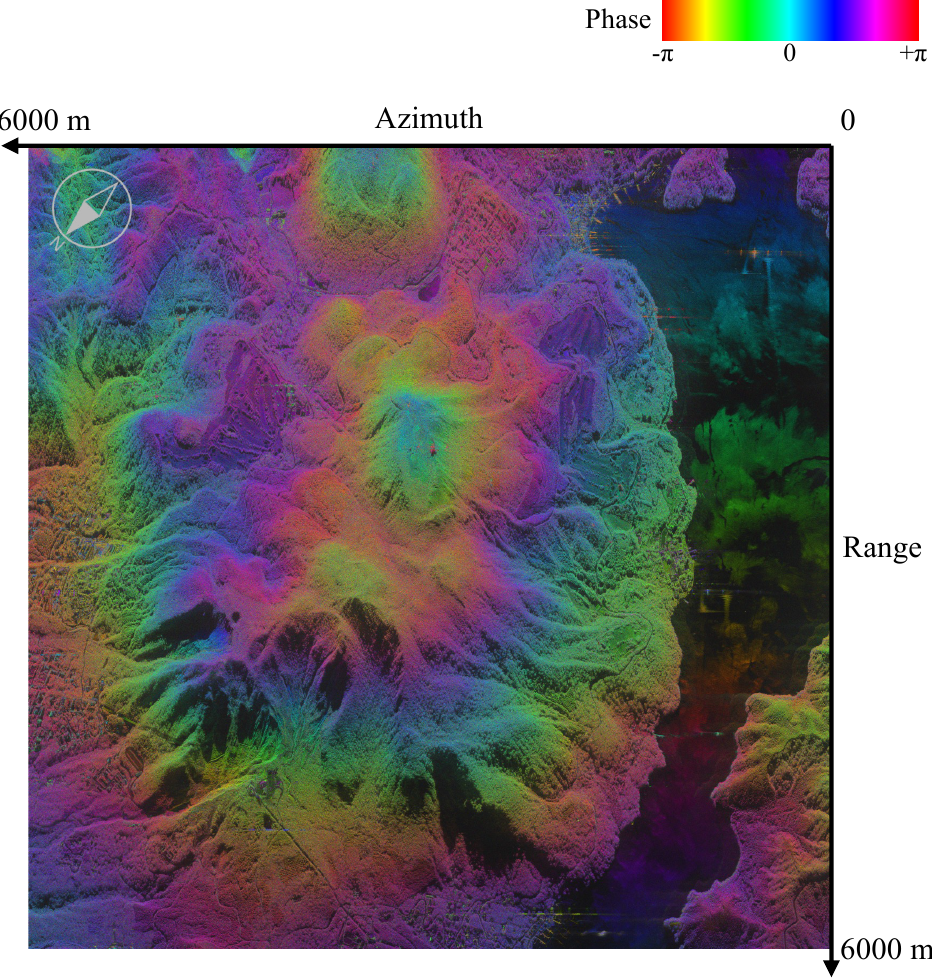
Figure 2. MGP_VVm image around Mount Hakone on 3 December 2015 (Center: N35.218,